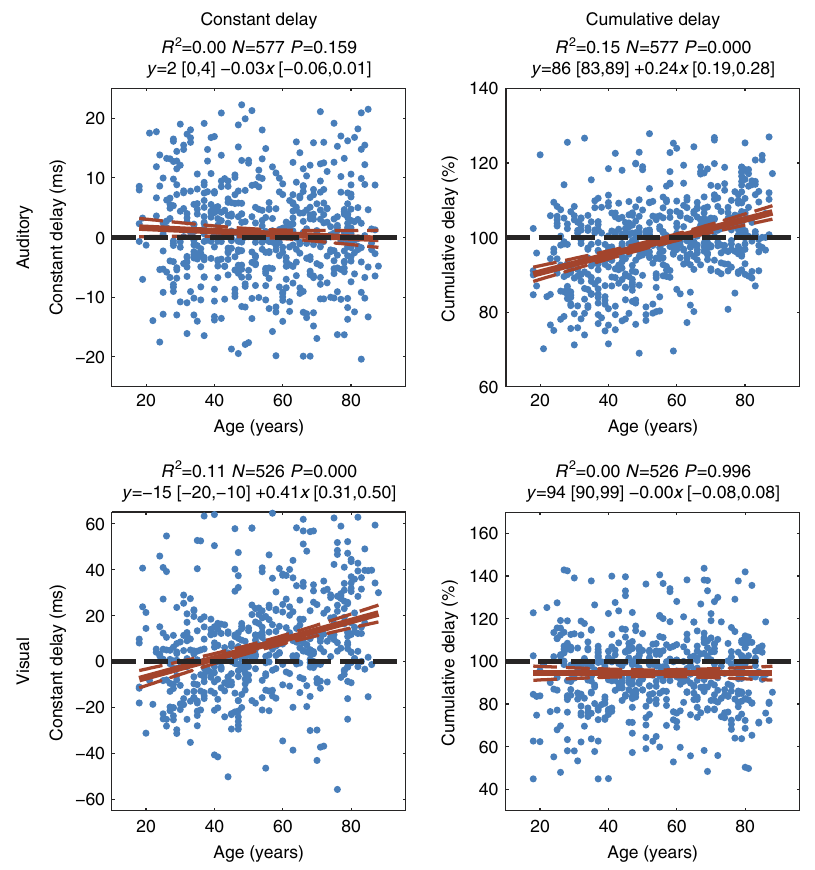
Figure 2 | Robust regressions with age of the two delay parameters for each stimulus modality in the Passive task. There is a significant effect of age on constant but not cumulative delay in the VEF, and a significant effect of age on cumulative but not constant delay in the